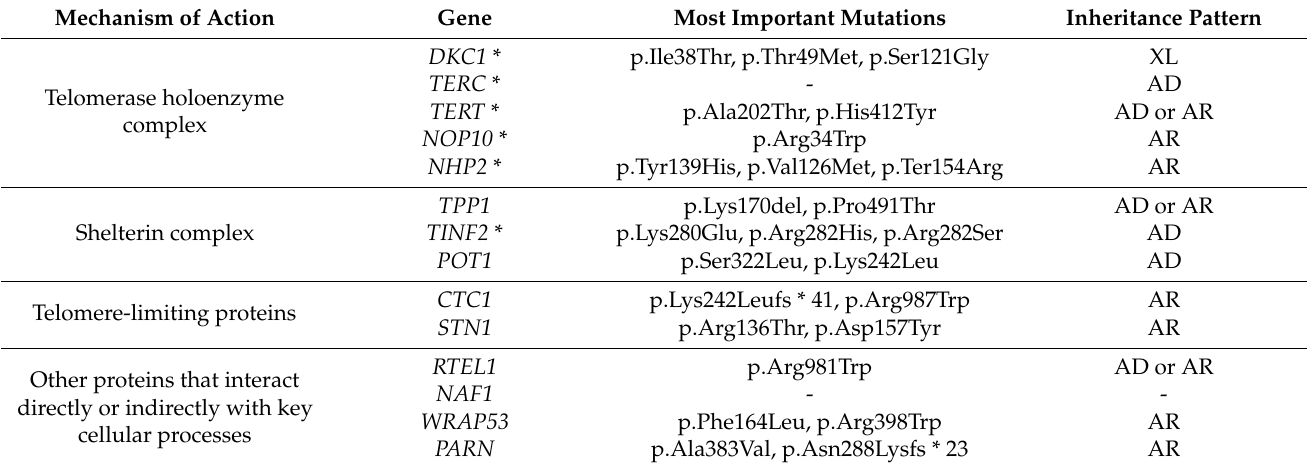
Table 1. Genes responsible of abnormalities in telomere biology responsible of dyskeratosis congenita. Gene Most Important Mutations Inheritance